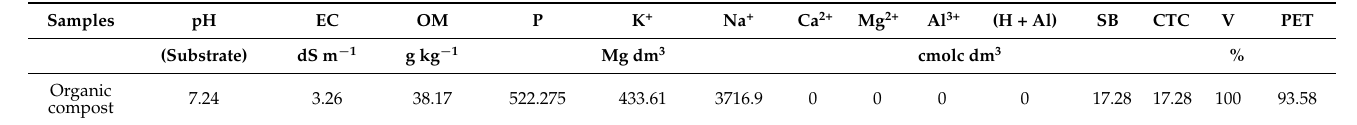
Table 1. Analysis of the organic source used in fertilizing plants.